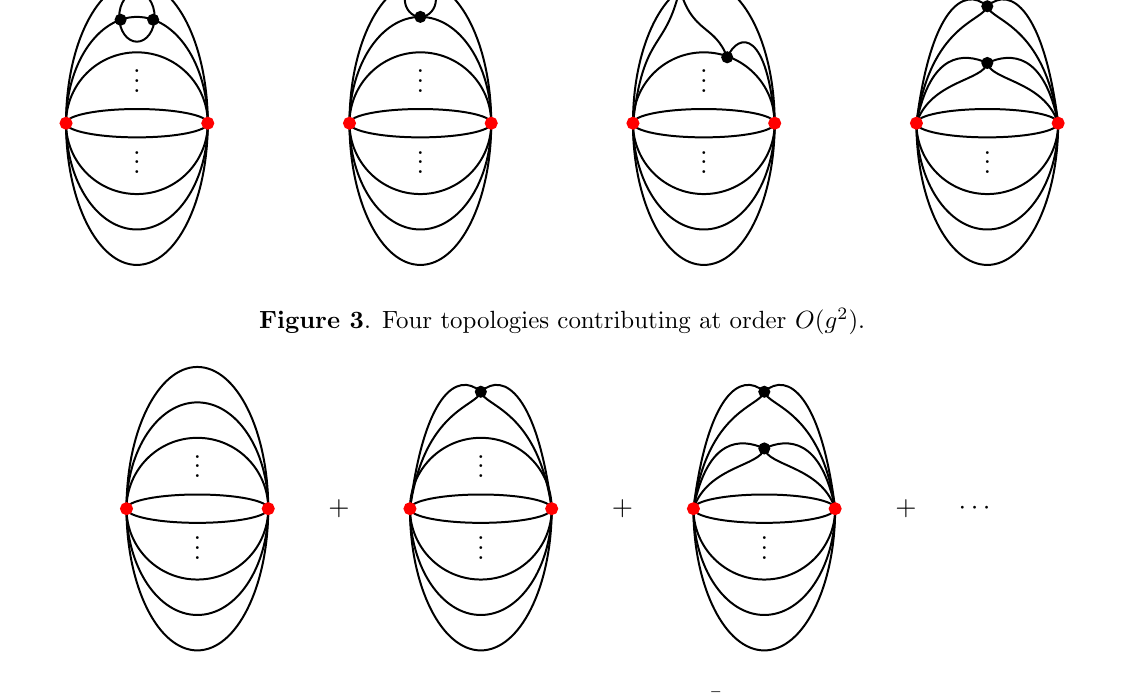
Figure 4 . Diagrams contributing to h O n ( x ) (cid:22) O n ( x ) i at large n